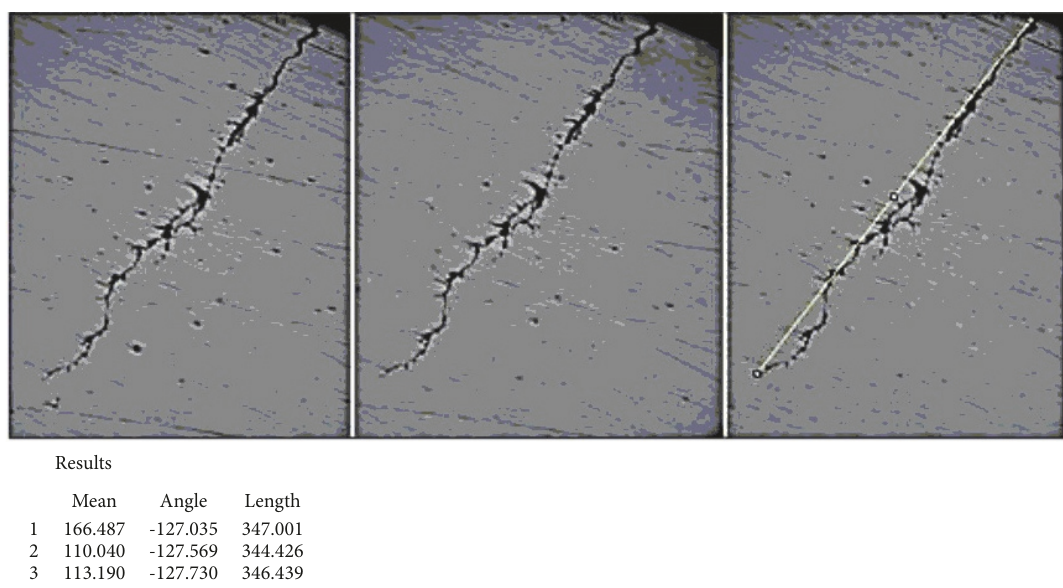
Figure 8: Results of crack depth stepwise measurement in the base metal of model sample.